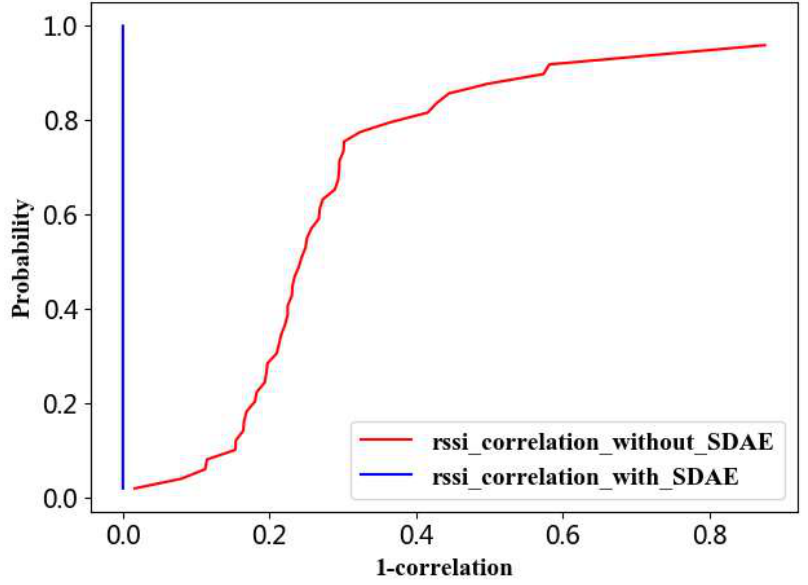
Figure 4. Correlation of RSSI samples of the original Wi-Fi data and the new-collected Wi-Fi data at the same position before SDAE and after SDAE.